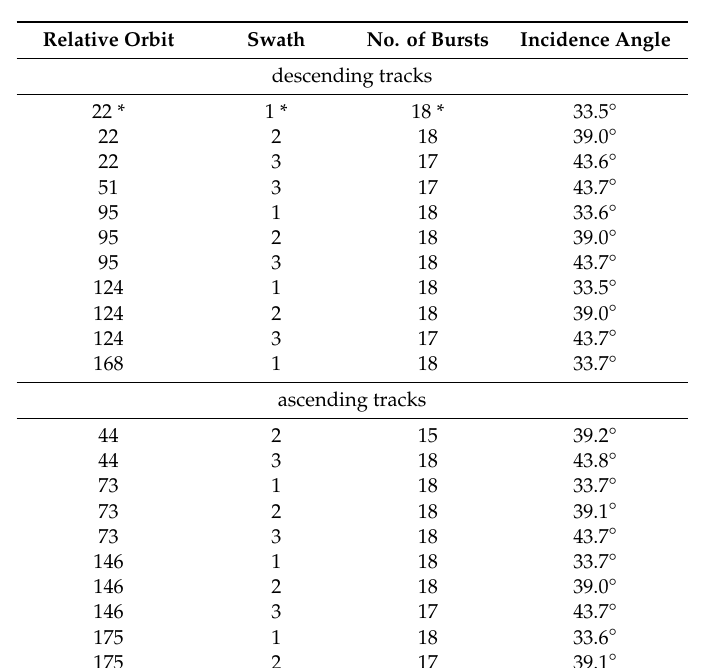
Figure 1. Projected Sentinel-1 centre lines for IW2 swaths of ( a ) ascending pass and ( b ) descending pass relative orbital tracks covering Czechia. Arrows depict direction of the satellite during each pass. Rectangles are projected burst units distributed within one Single Look Complex (SLC) data file from relative orbit 146 ( a ) and 124 ( b ). Table 1. Coverage of Sentinel-1 data over Czechia (all except marked * are active within the processing by